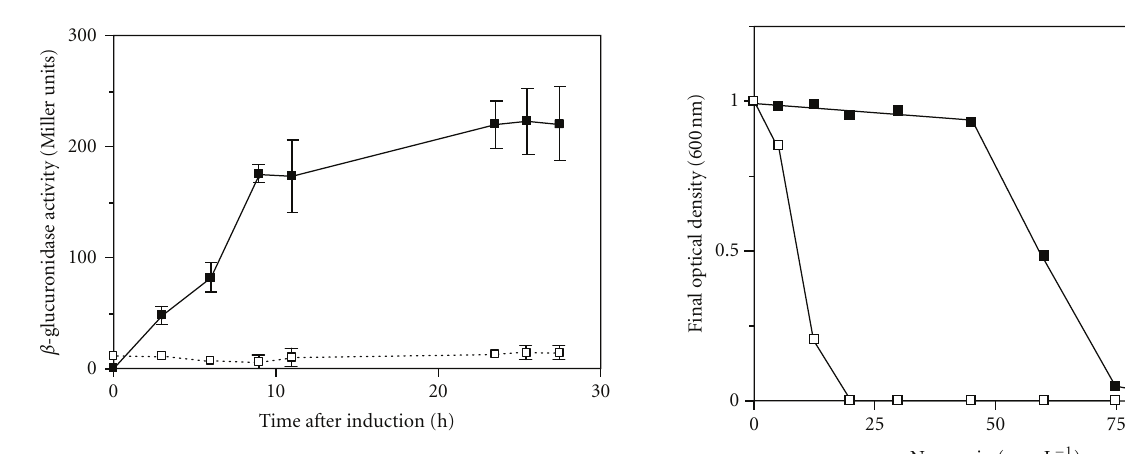
Figure 2: β -glucuronidase activity in cell extract of Ms. mazei after induction of protein production with trimethylamine. ( (cid:2) ) Cultures harboring the plasmid pSM01-uidA-Strep (pWM321-p1687-uidA- Strep). ( (cid:3) ) Cultures harboring the plasmid pWM321-uidA without the promoter p1687.